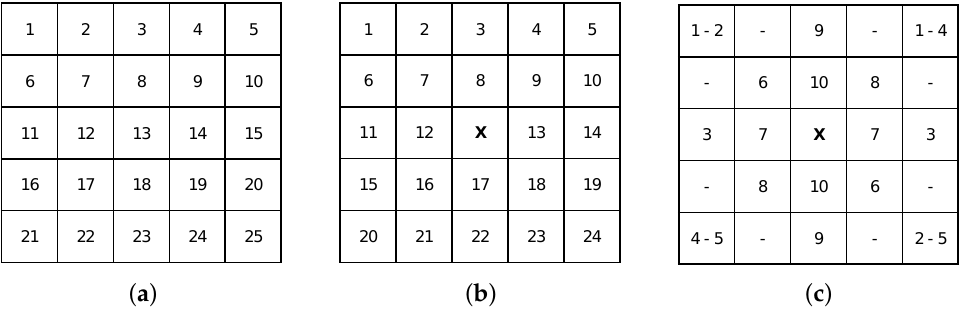
Figure 5. Positioning of obstacles for the reconstruction experiments: ( a ) a single obstacle was positioned in one of the possible ROI positions. ( b ) One obstacle was fixed at the ROI centre (X) and another was placed in one of the remaining possible positions. ( c ) Three obstacles were used, with one fixed at the ROI central position and the other two placed in the positions indicated by numbers 1 to